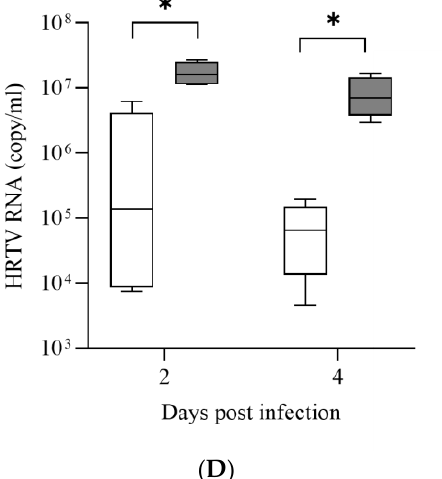
Figure 1. IFNAR − / − mice were infected with 1 × 10 7 TCID 50 of HRTV subcutaneously (closed circles), intraperitoneally (closed squares), or retro-orbitally (closed triangles). ( A ) Survival rate of the infected IFNAR −/− mice ( n = 3). ( B ) Sequential changes in bodyweights of IFNAR −/− mice ( n = 3). Relative weights were calculated and are shown as means with standard deviations. ( C ) The copy numbers of HRTV RNA in blood samples collected from the infected IFNAR −/− mice on days 2, 4, 7, 11, and 14 postinfection ( n = 3). n.d.: not determined. n.t.: not tested. ( D ) Comparison of levels of HRTV RNA between IFNAR −/− mice that survived and those that died of HRTV infection. The white box and gray box indicate the HRTV RNA levels of the mice that survived and those that reached the endpoint, respectively. Significance was determined by Mann – Whitney test. * p < 0.05.